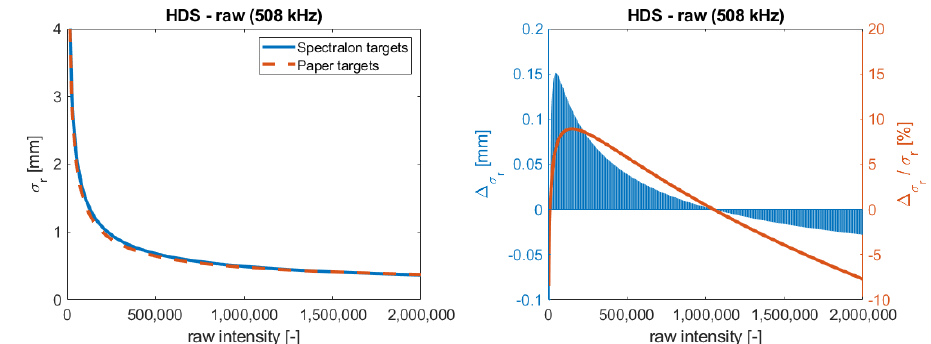
Figure 6. Comparison of functions estimated with Spectralon targets and with the paperboard setup.